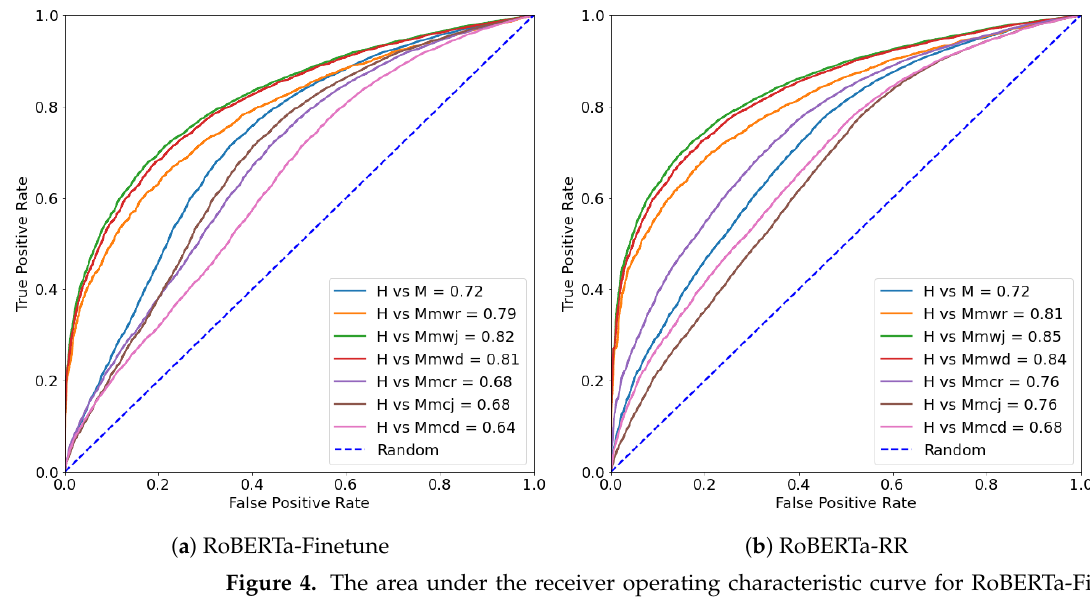
Figure 4. The area under the receiver operating characteristic curve for RoBERTa-Finetune and RoBERTa-RR in different classification cases for in-distribution